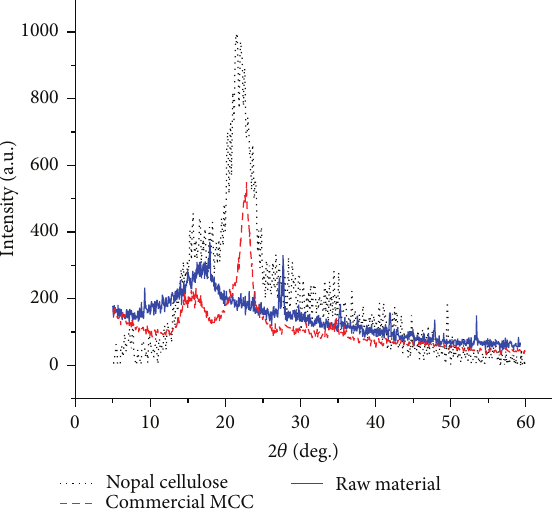
Figure3:Infraredspectroscopyofrawmaterial,nopalcellulose,and commercial microcrystalline cellulose.